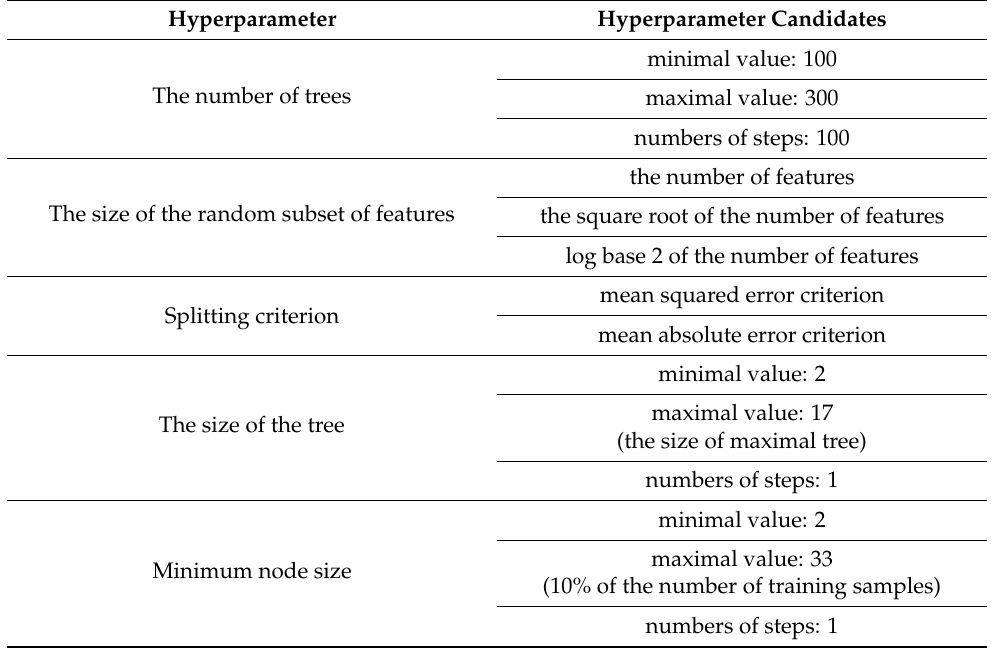
Table 4. The hyperparameter space of